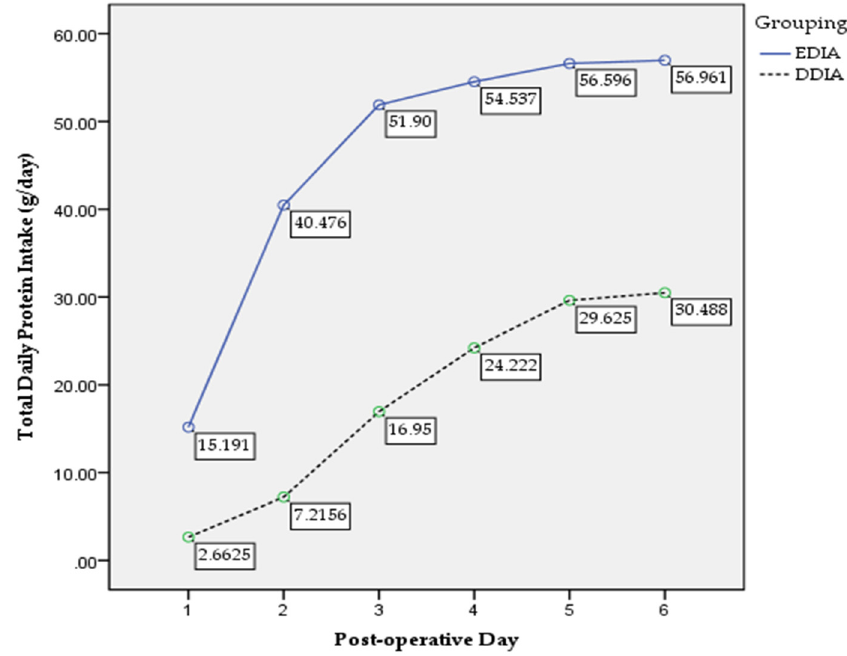
Figure 2. Postoperative total daily energy intake trend.